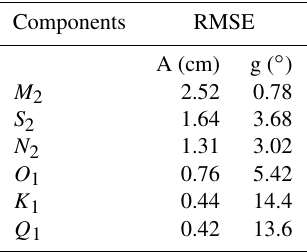
Table 2. Computed RMSE for the main harmonic components, the validation for each tide gauge is reported in the Table